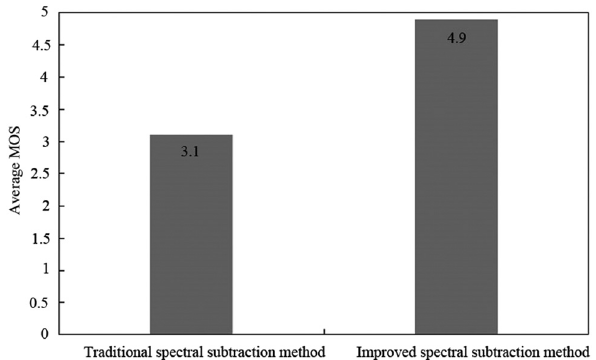
Figure 4: The average MOS of music signals processed by the two spectral subtraction